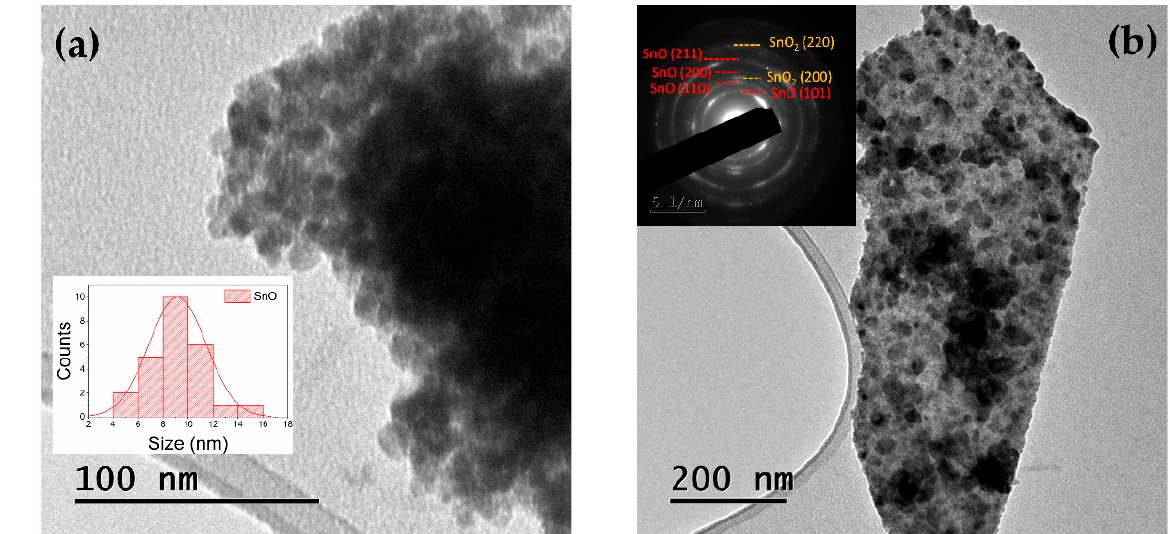
Figure 1. TEM image of the as-synthesized SnO nanopowder, showing ( a ) nanoparticles and ( b ) plate-like structures. Inset in ( a ) shows the histogram with the average dimensions, while inset in ( b ) shows the corresponding selected area electron diffraction (SAED) pattern.